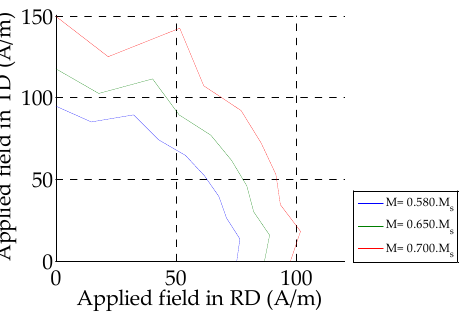
Figure 2. Polar representation of the magnetic field at three magnetization level of a NO SiFe sample.